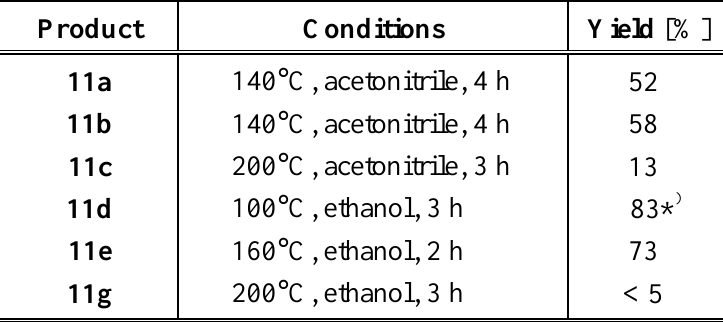
Table 1. Reaction conditions and the